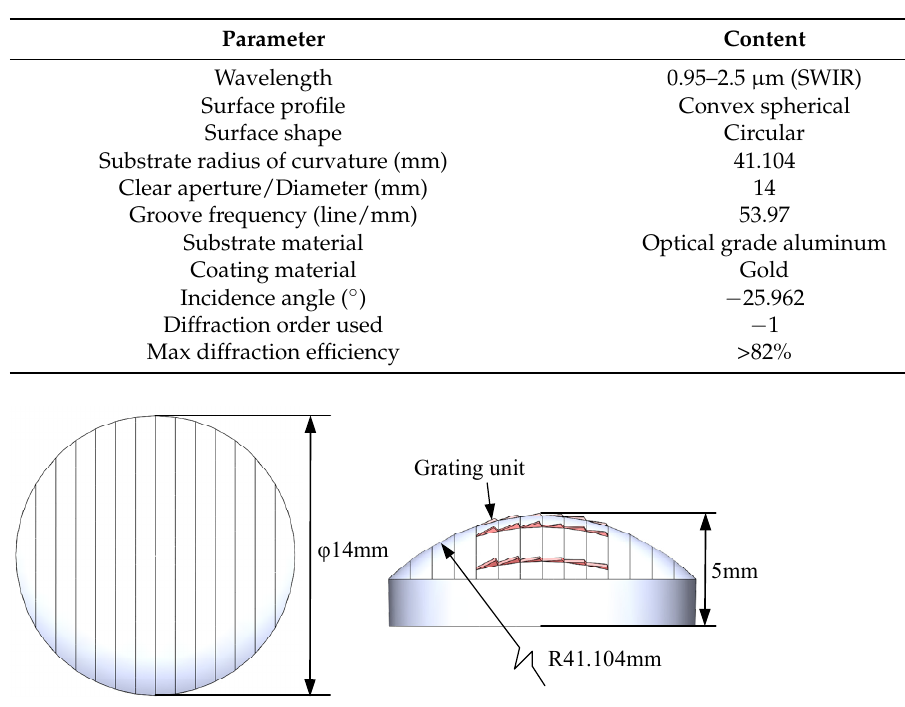
Table 1. Specifications of convex spherical grating.